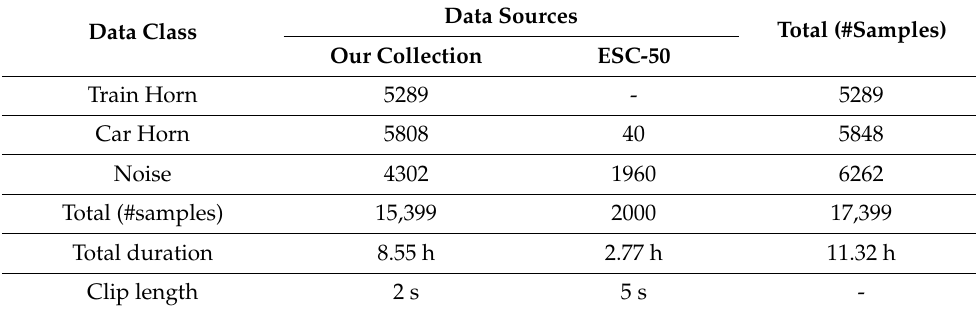
Table 1. The summary of our data preparation.